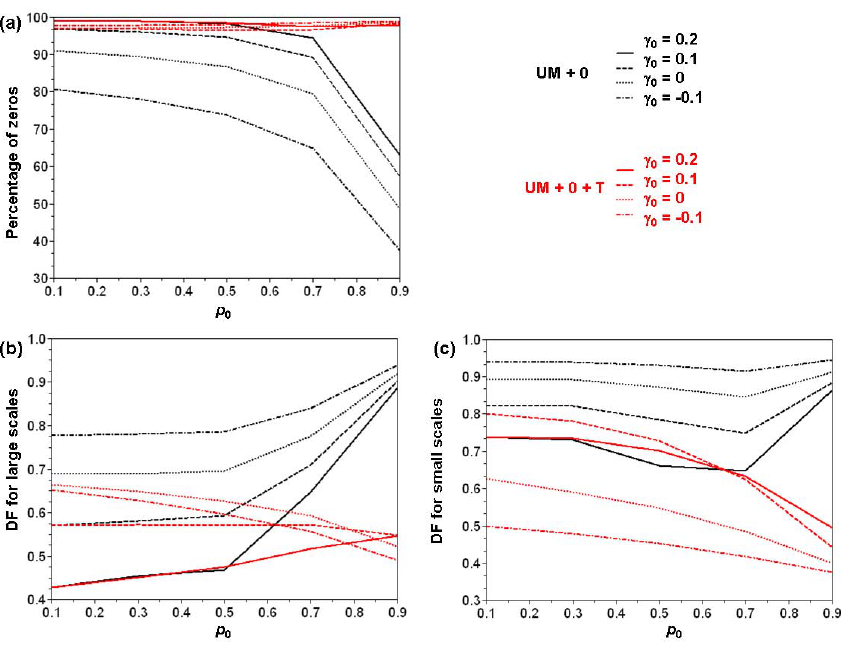
Fig. 6. Analysis of the sensitivity to γ 0 and p 0 : percentage of zero (a) , D F for large scales (b) and D F for small scales (c)